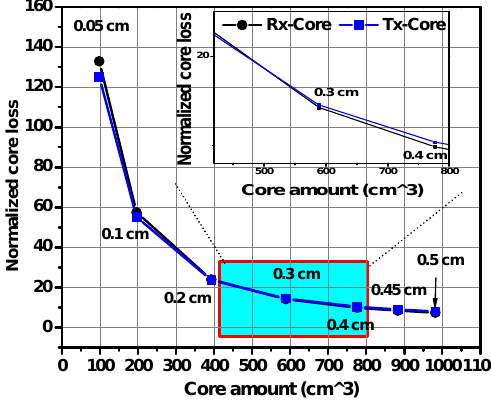
Figure 6. Tx and Rx core losses vs. core